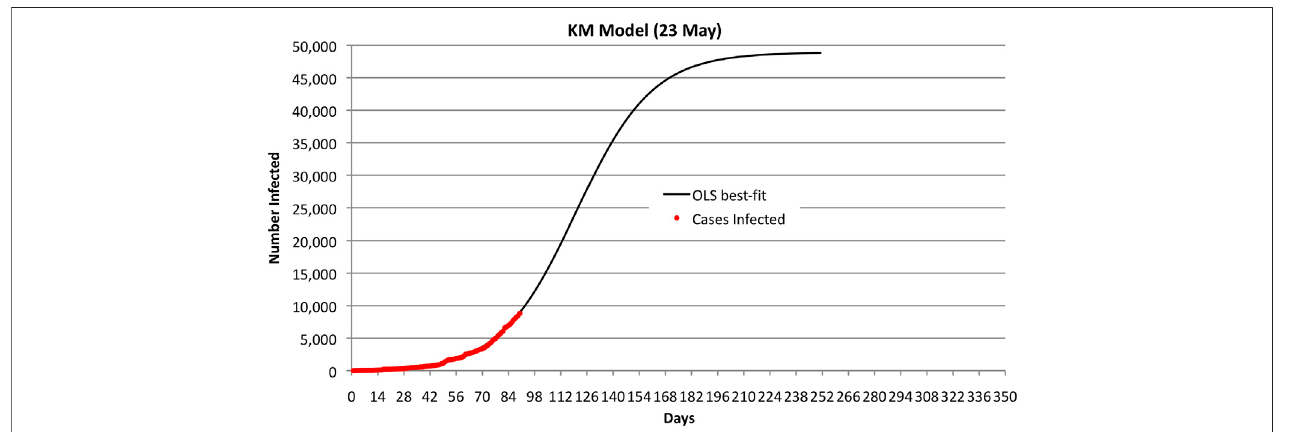
FIGURE 1 | Bahrain KM OLS best fi t and observed number of infected cases through 23 May 2020. Note that the curve predicts 50,000 cases.